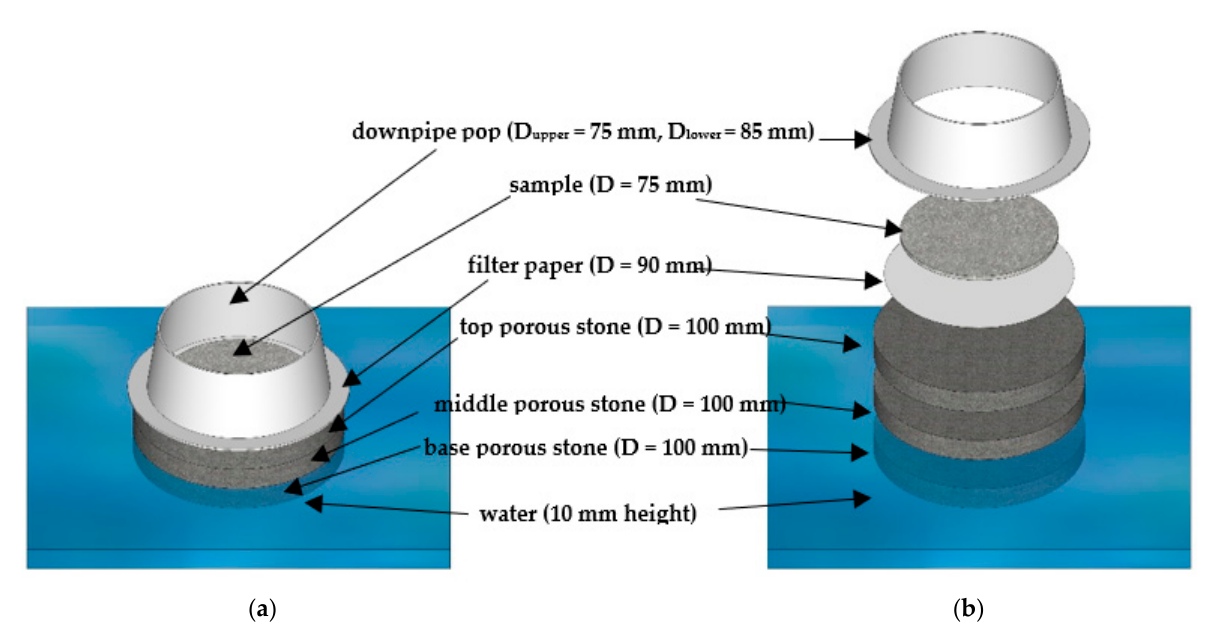
Figure 2. Schematic figure of the proposed IWU test: ( a ) side-view; and ( b ) sliced side-view.